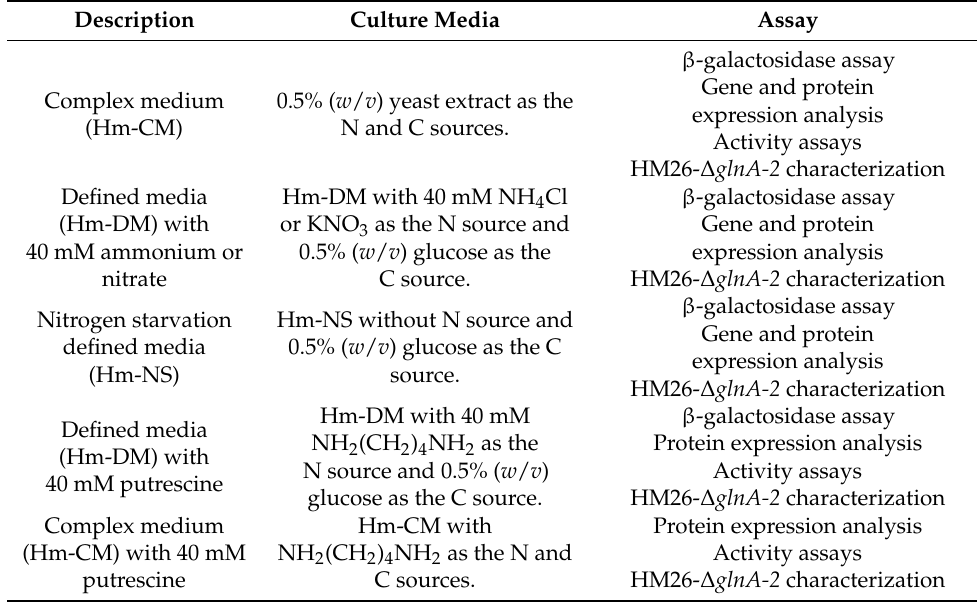
Table 1. Culture media used to grow Hfx . mediterranei